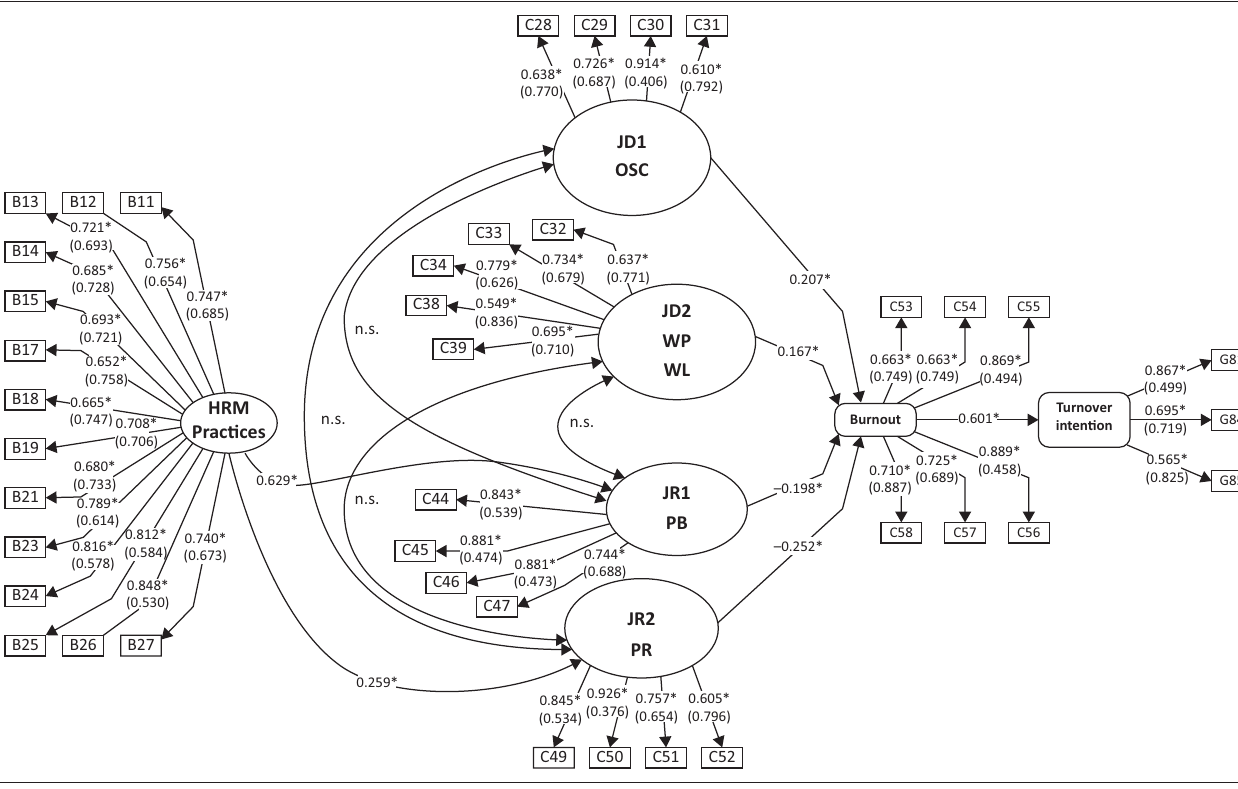
FIGURE 3: Tested and modified Model 1 - Prediction of Turnover